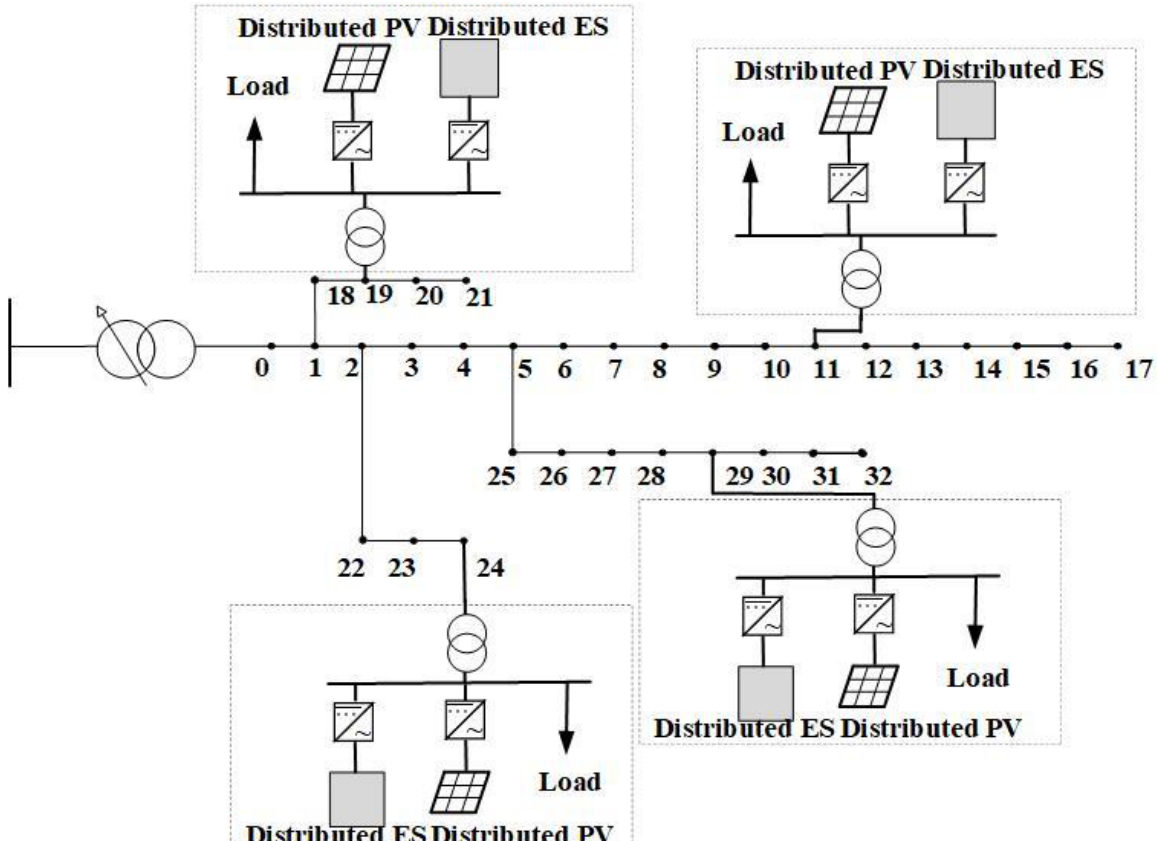
Figure 2. The structure of improved IEEE 33-node